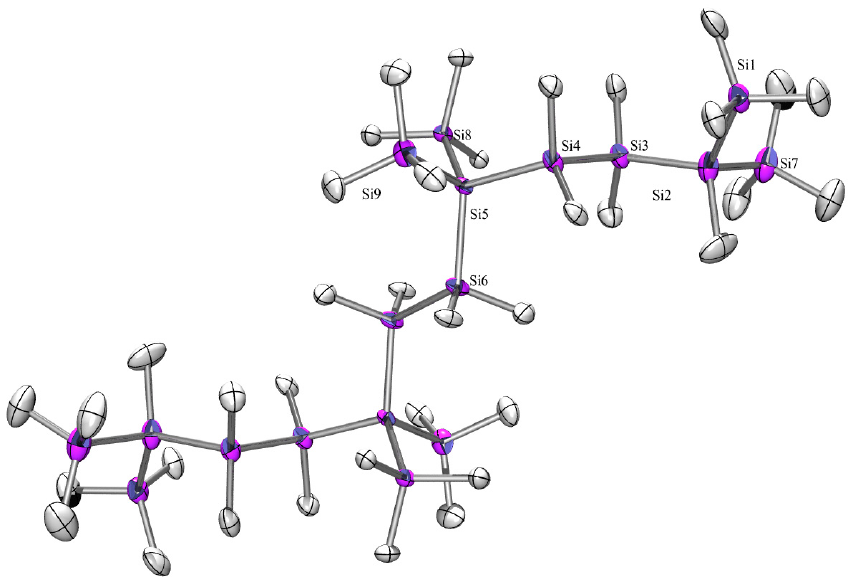
Figure 12. Crystal structure of 14 . Thermal ellipsoids are represented at the 30% level and hydrogen atoms have been omitted for clarity (bond lengths in Å, angles in deg). Si(1)-C(1) 1.875(11), Si(1)-Si(2) 2.358(5), Si(2)-Si(7) 2.333(5), Si(2)-Si(3) 2.357(4), Si(3)-Si(4) 2.342(4), Si(4)-Si(5) 2.379(3), Si(5)-Si(8) 2.354(3), Si(5)-Si(9) 2.371(3), Si(5)-Si(6) 2.376(3), Si(7)-Si(2)-Si(3) 108.05(16), Si(7)-Si(2)-Si(1) 109.16(18), Si(3)-Si(2)-Si(1) 116.28(17), Si(4)-Si(3)-Si(2) 111.55(15), Si(3)-Si(4)-Si(5) 117.83(13), Si(8)-Si(5)-Si(9) 107.50(13), Si(8)-Si(5)-Si(6) 116.91(12), Si(9)-Si(5)-Si(6) 109.33(14), Si(8)-Si(5)-Si(4) 110.18(12), Si(9)-Si(5)-Si(4) 103.60(13), Si(6)-Si(5)-Si(4) 108.51(13).